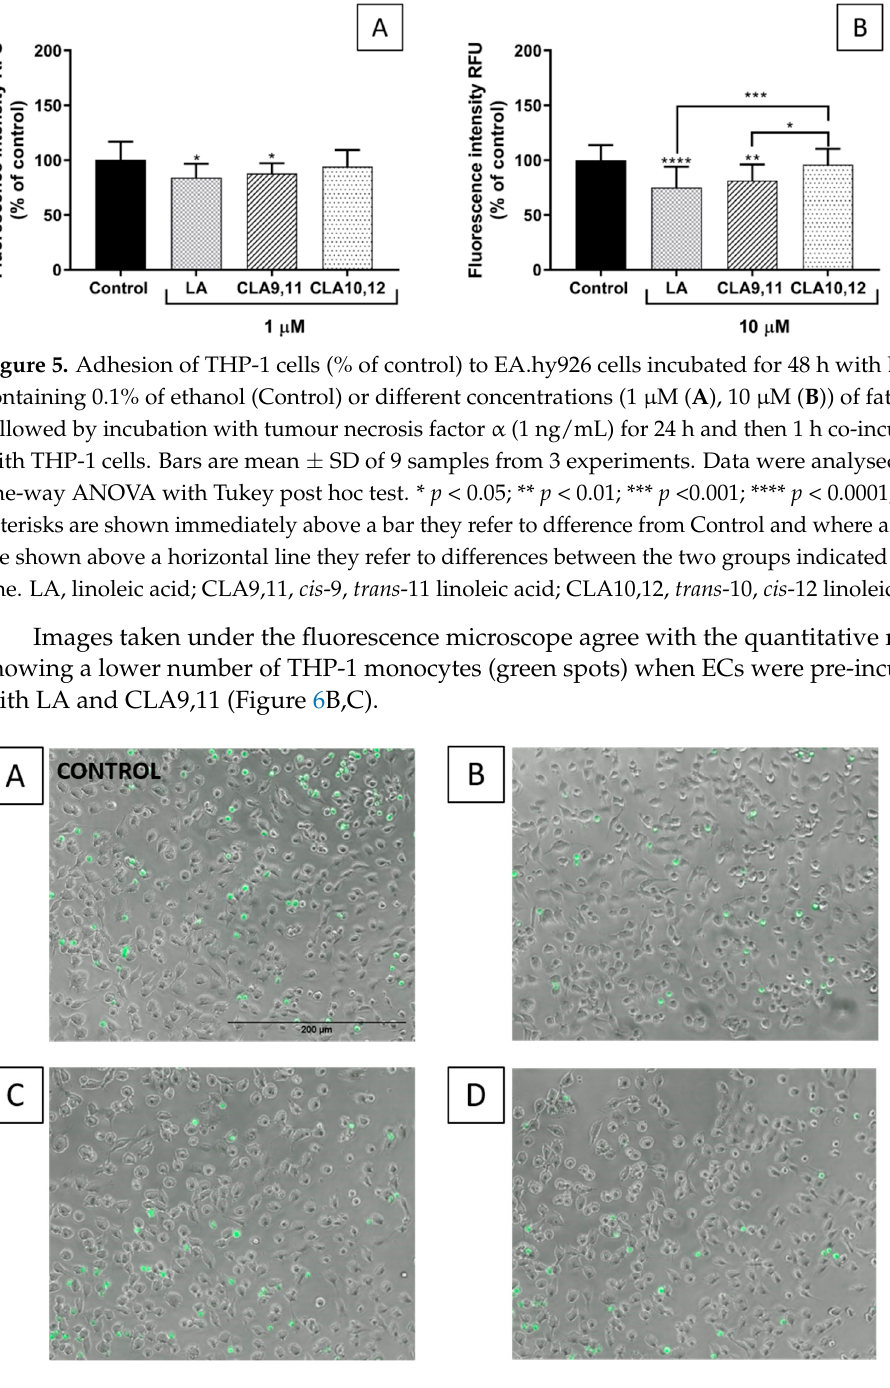
Figure 6. Images of THP-1 cell adhesion to EA.hy926 cells. Adhesion of THP-1 cells to EA.hy926 cells without pre-incubation with fatty acid (control ( A )) or with 48 h prior exposure to 10 μ M linoleic acid ( B ), cis -9, trans -11 linoleic acid ( C ), trans -10, cis -12 linoleic acid ( D ), followed by incubation with tumour necrosis factor α (1 ng/mL) for 6 h and then 1 h co-incubation with calcein labelled THP-1 cells. Attached THP-1 cells were visualised by fluorescence microscopy (Nikon Elipse Ti) at a magnification of 100 × under transmitted light.